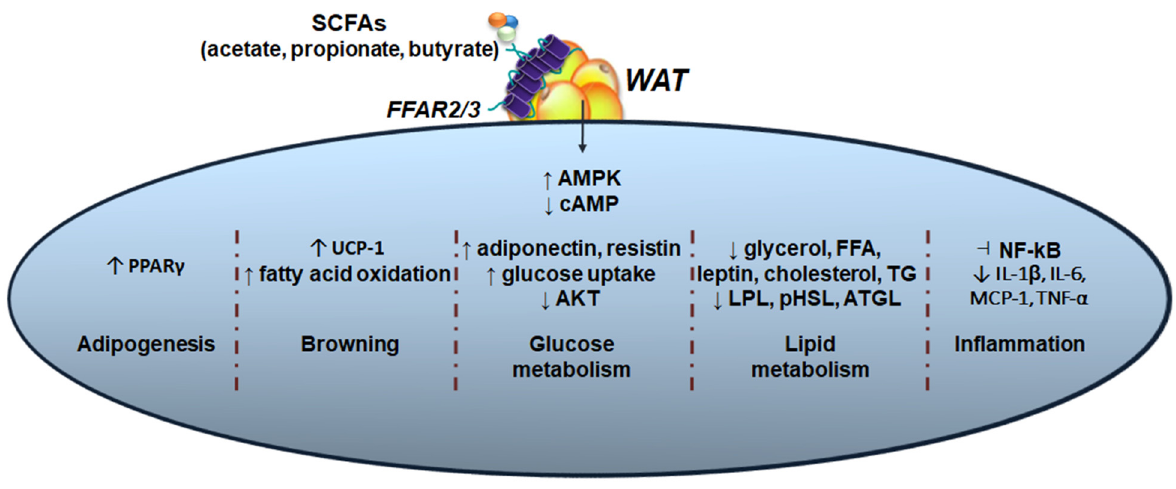
Figure 3. SCFA-FFAR2/3 signaling pathways in adipose tissue . Gut bacterial SCFA-activated free fatty acid receptors 2 and 3 (FFAR2/3) modulate host adipose tissue physiology, thus regulating body weight and whole-body metabolic homeostasis. In white adipose tissue (WAT), studies indi- cate that SCFA-FFAR2/3 putatively impact nutritional status and energy balance through signaling